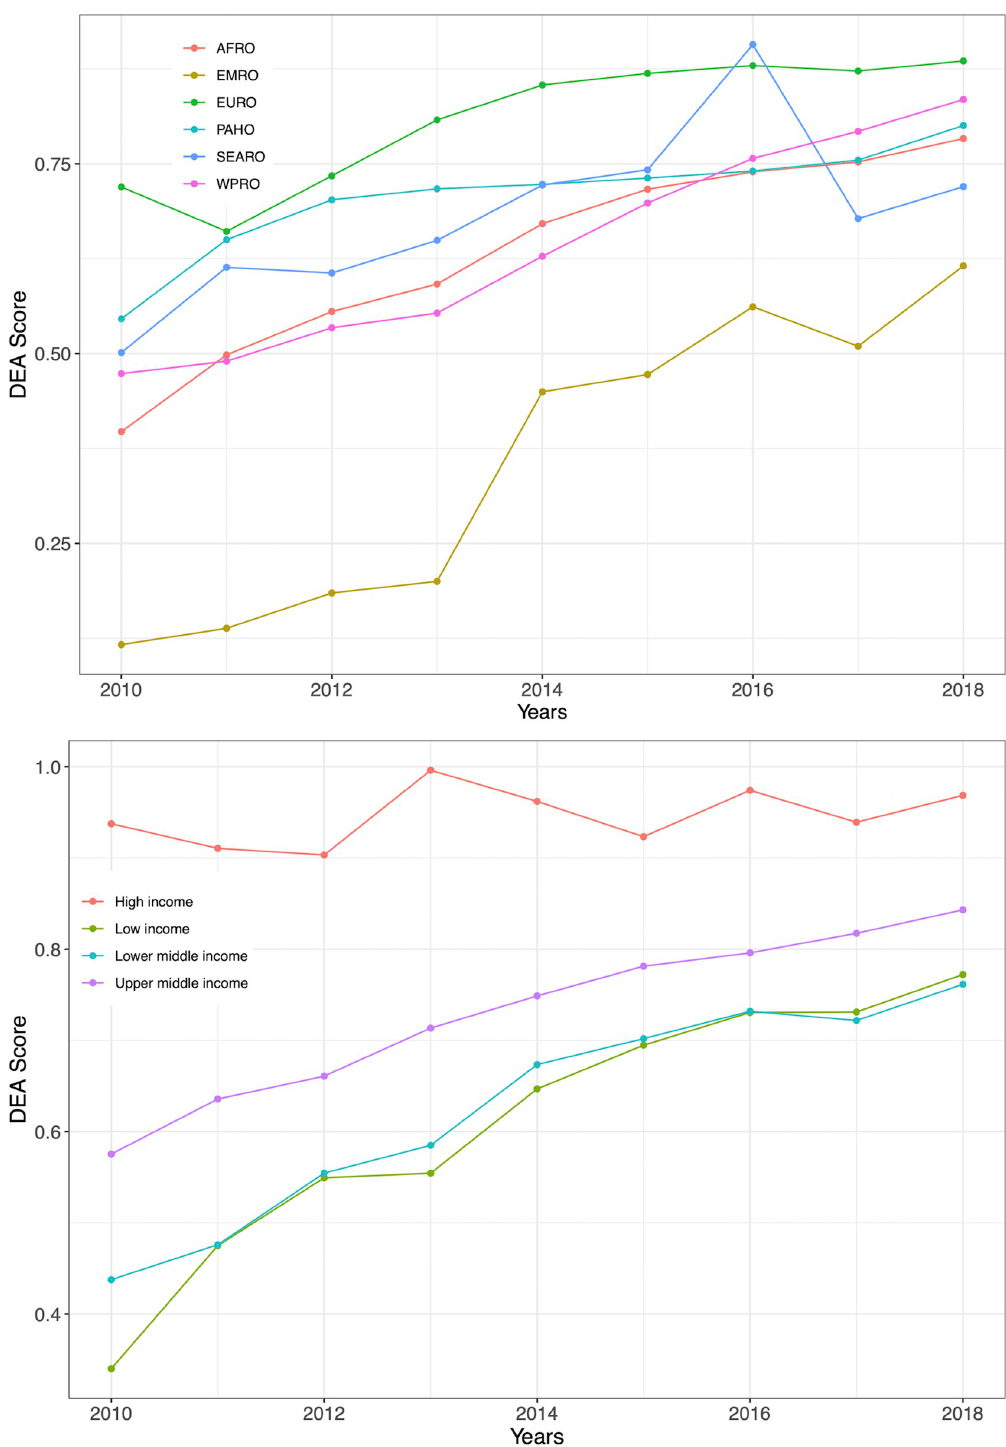
Fig 5. Average bias-corrected efficiency scores by WHO region and WB income group. Notes : Values extracted from the base model. Same graph by UNAIDS region is shown in Fig E of Section B in S1 Text. DEA scores stand for efficiency scores.